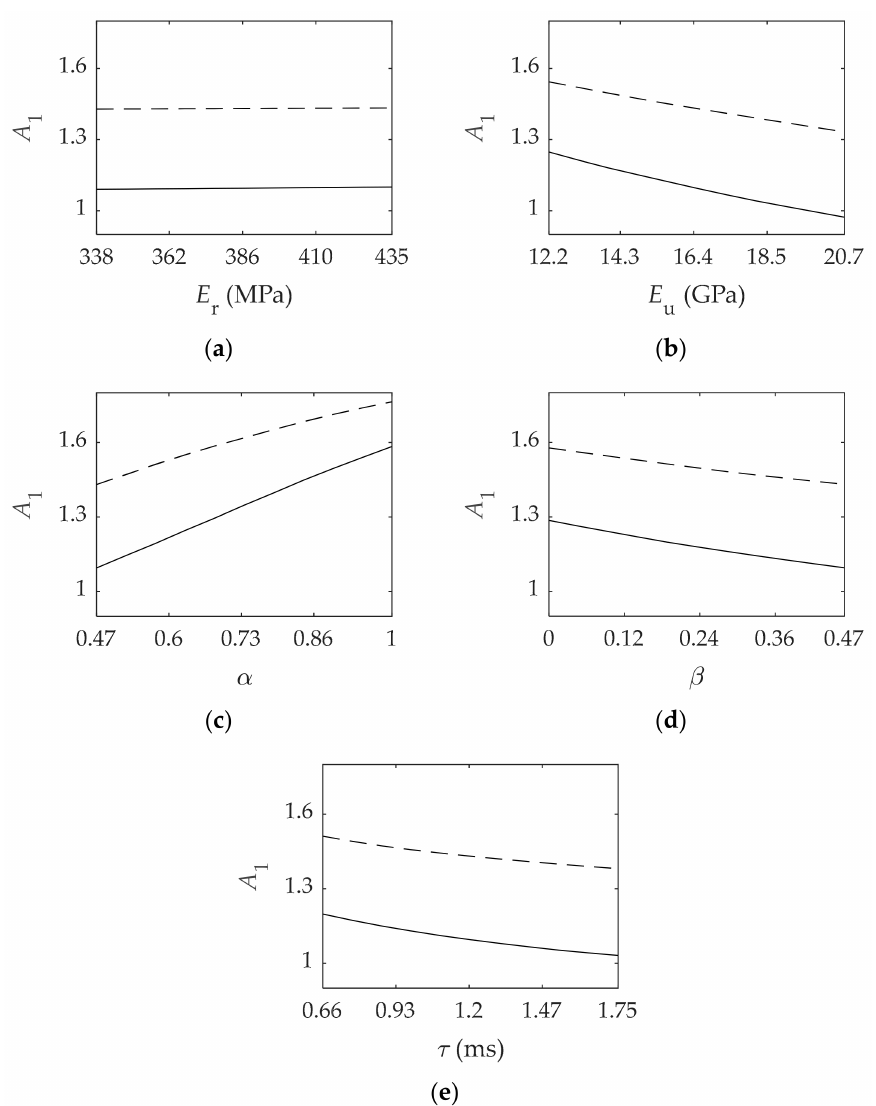
Figure 4. Viscoelastic material parameters influence on the ratio between the amplitude of the first maximum and the stationary response A 1 for the asymmetrical (